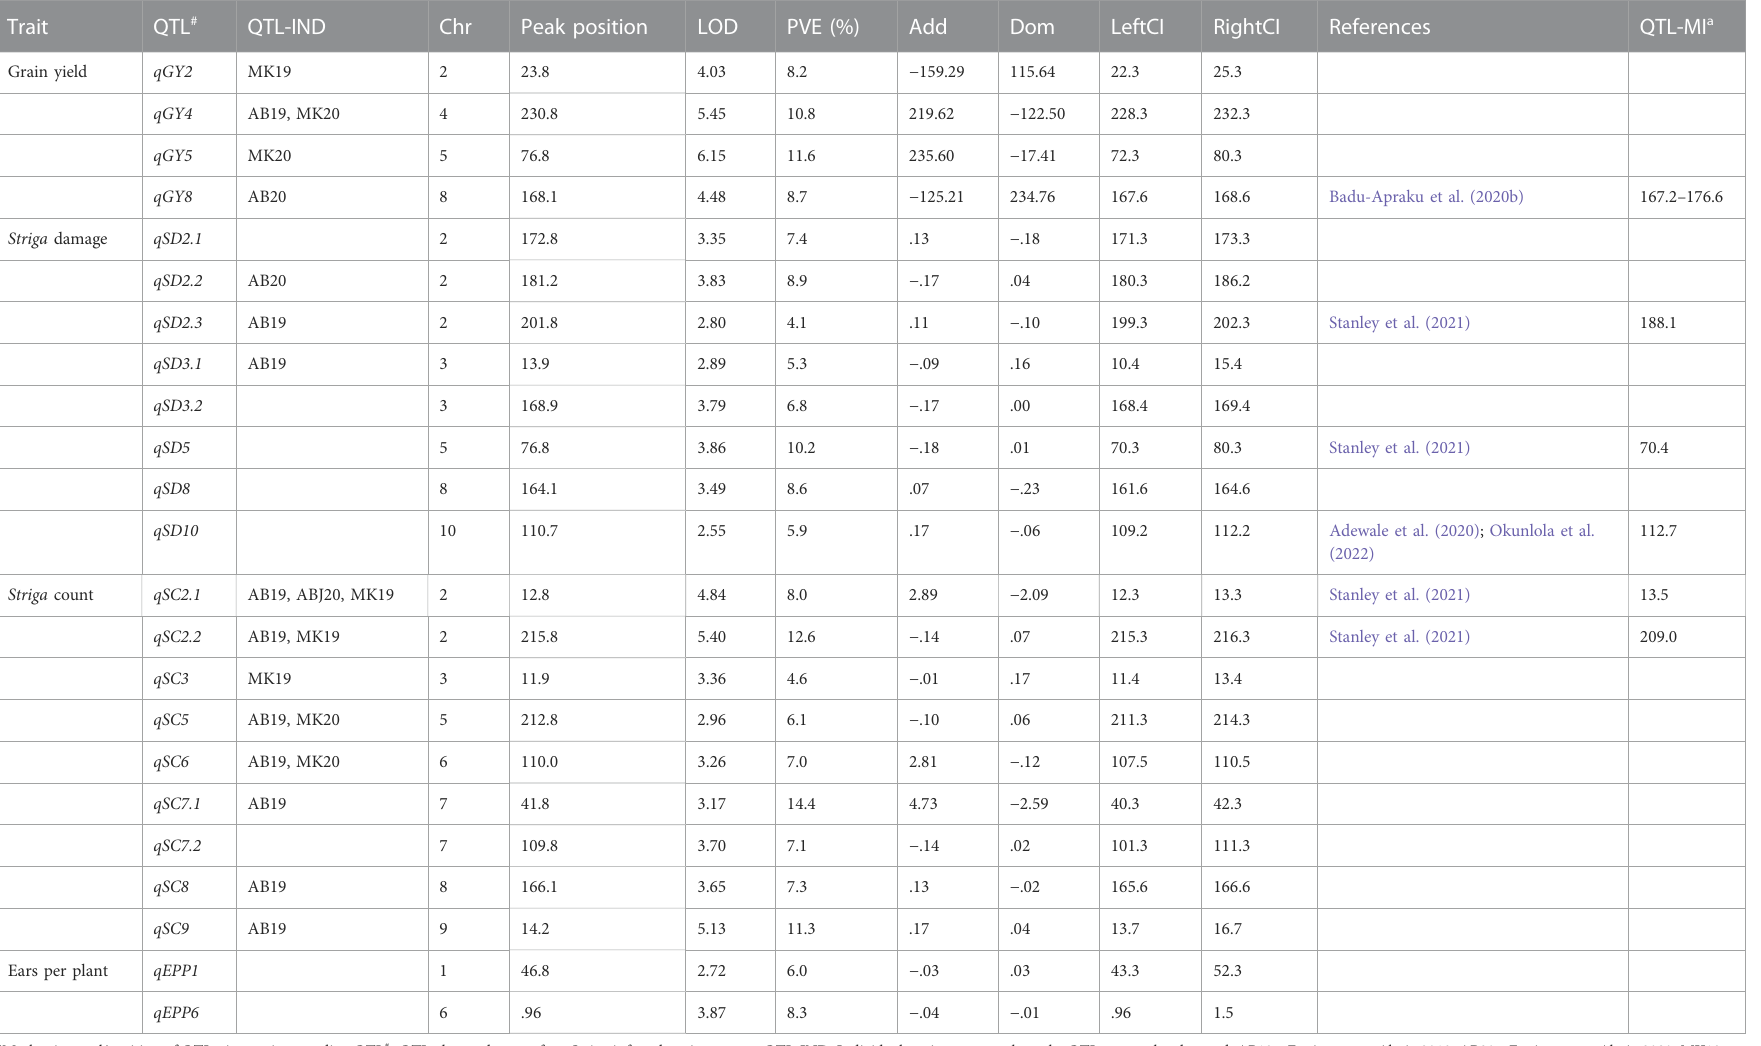
TABLE 4 Quantitative trait loci identi fi ed from F 2:3 mapping population derived from TZdEI 352 x TZEI 916 across four arti fi cial Striga infested environments in Nigeria, 2019-2020. Trait QTL # QTL-IND Chr Peak position LOD PVE (%) Add Dom LeftCI RightCI QTL-MI a Grain